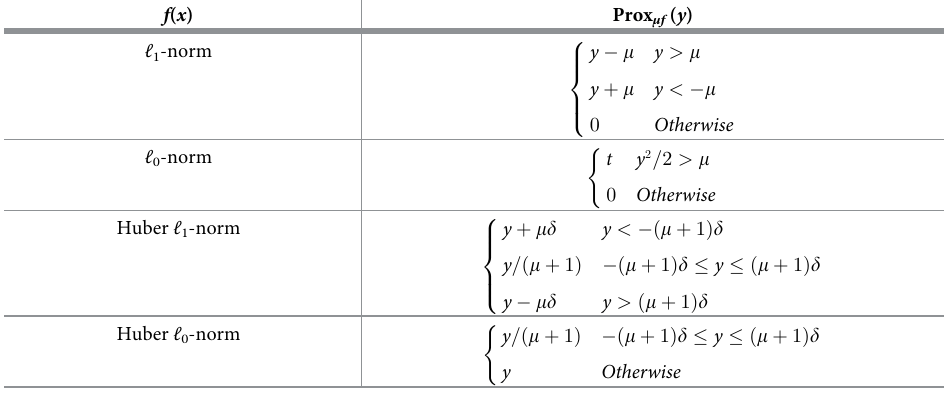
Table 1. Proximity operators corresponding to different sparsity-induced